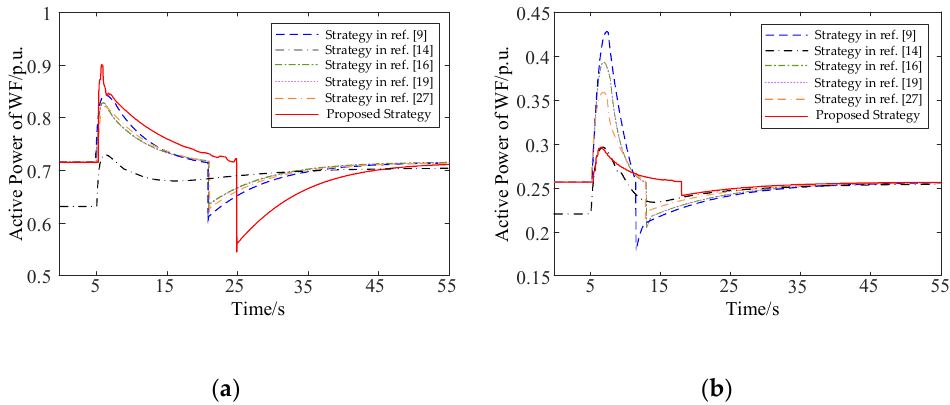
Figure 21. Active power of WF. ( a ) Active power of WF based on the operating conditions of Case 1 and ( b ) active power of WF based on the operating conditions of Case 2.